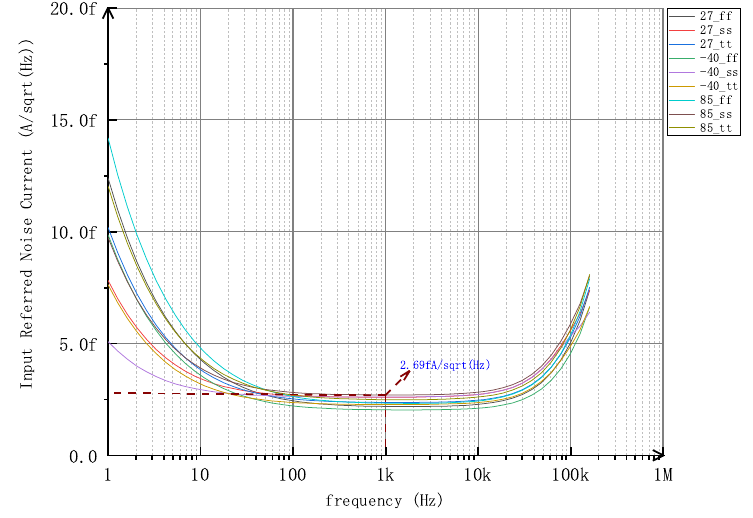
Figure 15. Noise performance of the TIA.